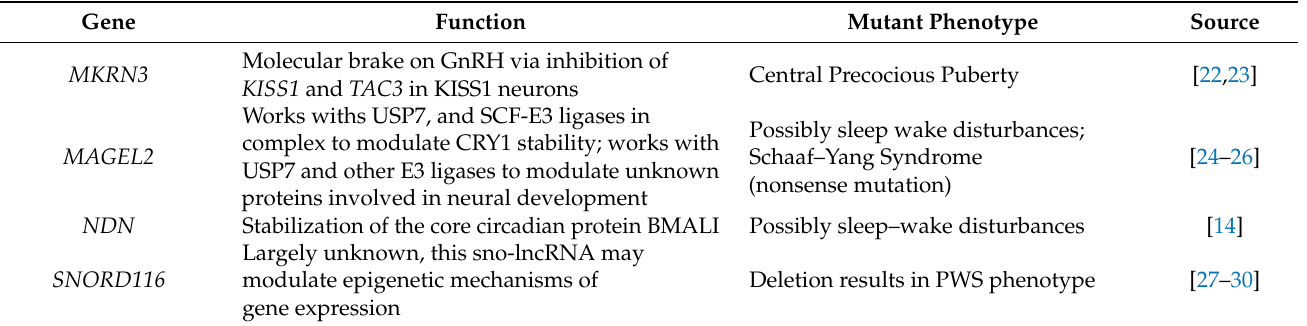
Table 1. Summary of recent findings of genes implicated in